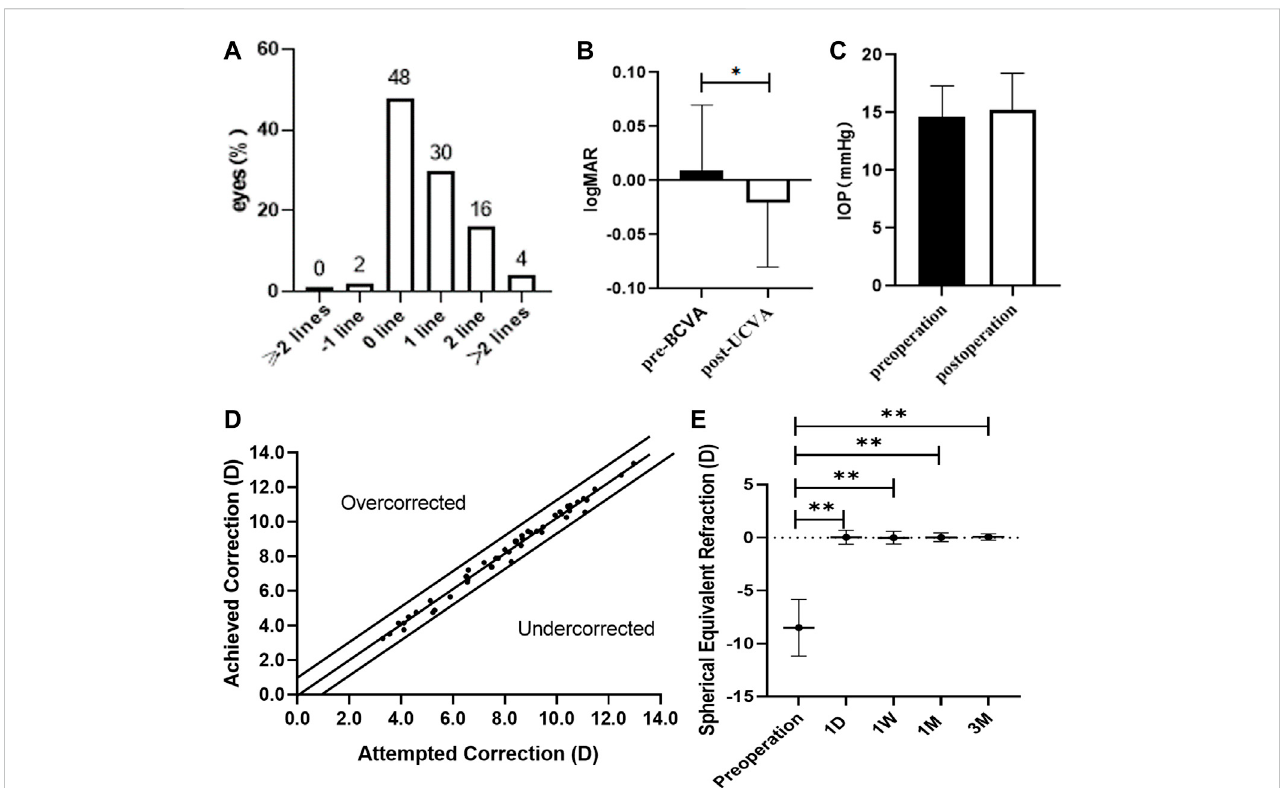
FIGURE 3 Clinical examinations of myopia patients after ICL implantation surgery. (A) Changes in Snellen lines of BCVA at 3 months after ICL implantation. (B) Changesbetween BCVA3 monthsafterICLimplantationandUCVAPreoperatively. (C) Changesinintraocularpressure3 monthsafter ICLimplantation. (D) A scatter plot of the attempted versus the achieved manifest spherical equivalent correction 3 months after ICL implantation. (E) Time course of manifest spherical equivalent after ICL implantation. The asterisks indicate statistically signi fi cant differences between pre-surgery and post-surgery. D, day; W, week; M,